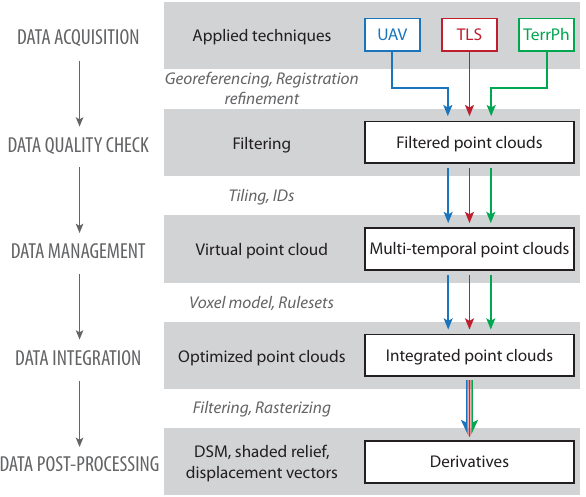
Figure 4. Workflow showing the main processing steps.